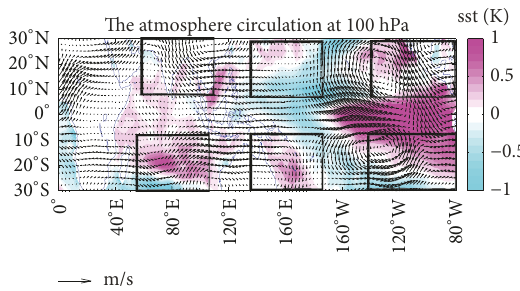
Figure 5: Composite wind field (arrows) and SST (color fill) at 100